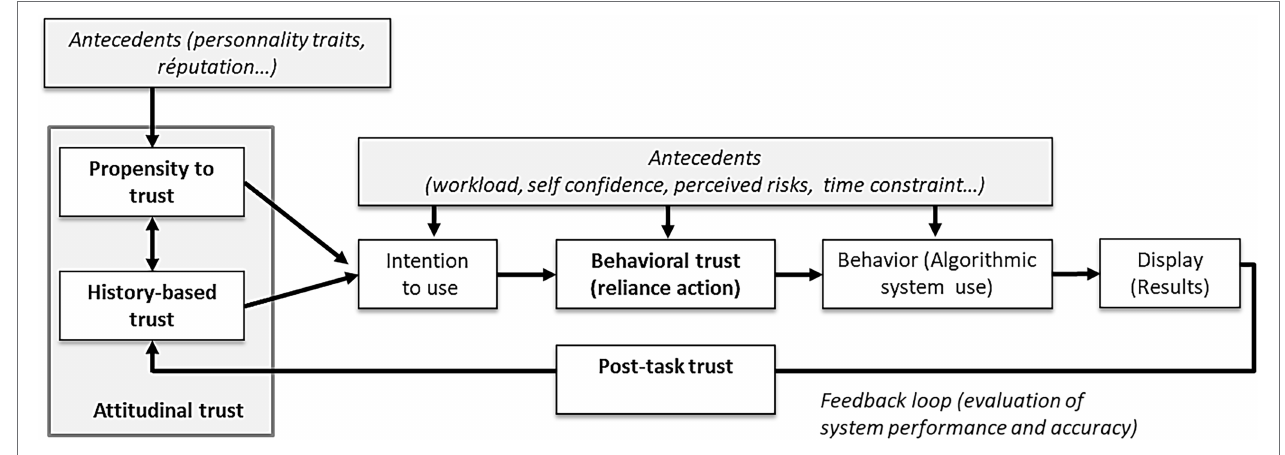
FIGURE 1 | Dynamic of trust in human–ADSS